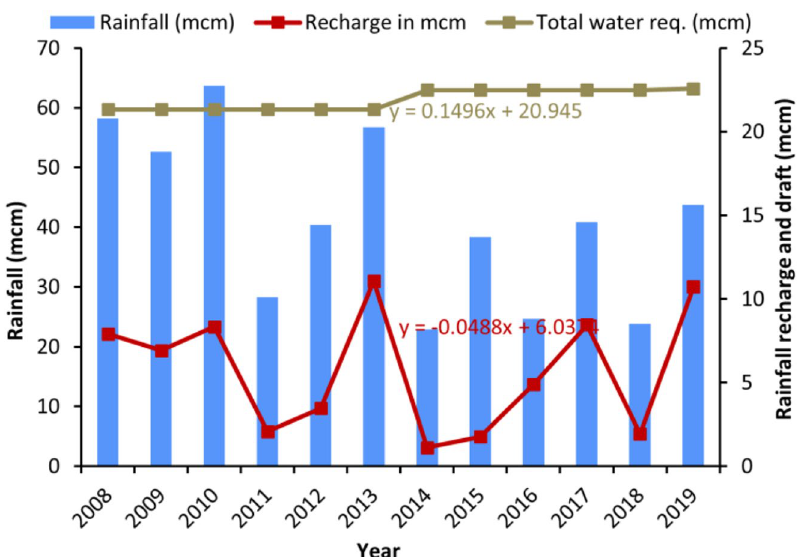
Figure 7. Graph showing the temporal variation of rainfall recharge and draft with respect to rainfall in the study